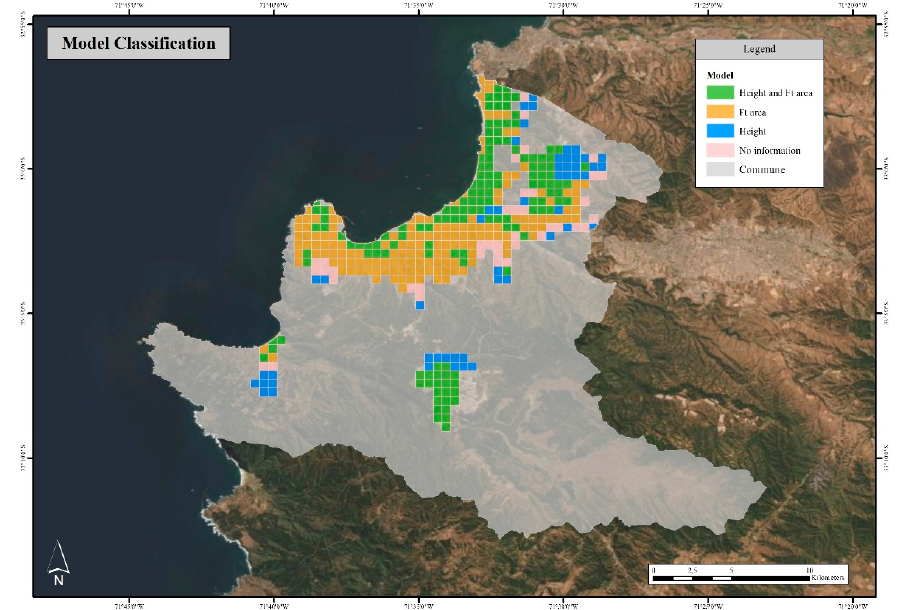
Figure A2. Categories according to the available input data in the study area, with 136 grid cells represented by green colour having information on build-up height according to [50] as well as the OSM footprint area (Section 3.2.3.1), 51 grid cells represented with blue colour having information about the build-up height and density from remote sensing data products (as studied by [50]), 158 grid cells represented by orange colour having a complete information only about the footprint area from OSM, and 39 grid cells represented by pink colour having no input information. Map data © Google Earth 2020. Figure modified from [50].